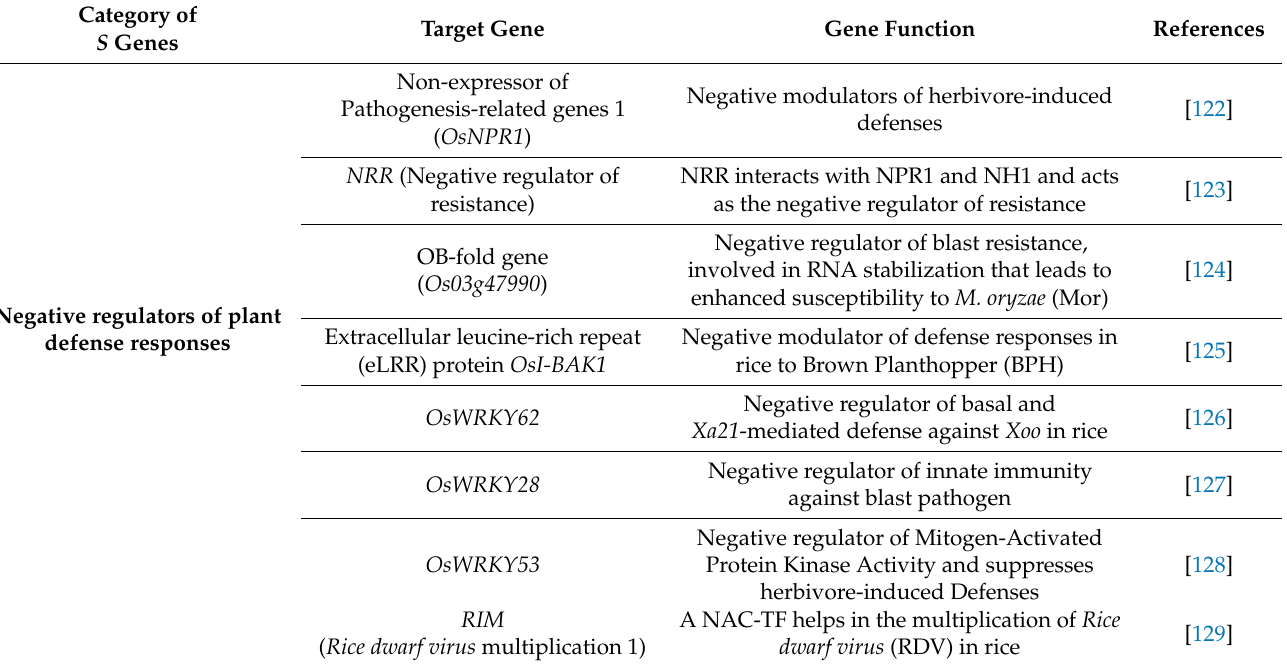
Table 5. List of unexplored susceptibility factors in rice as the possible target for genome editing. Category